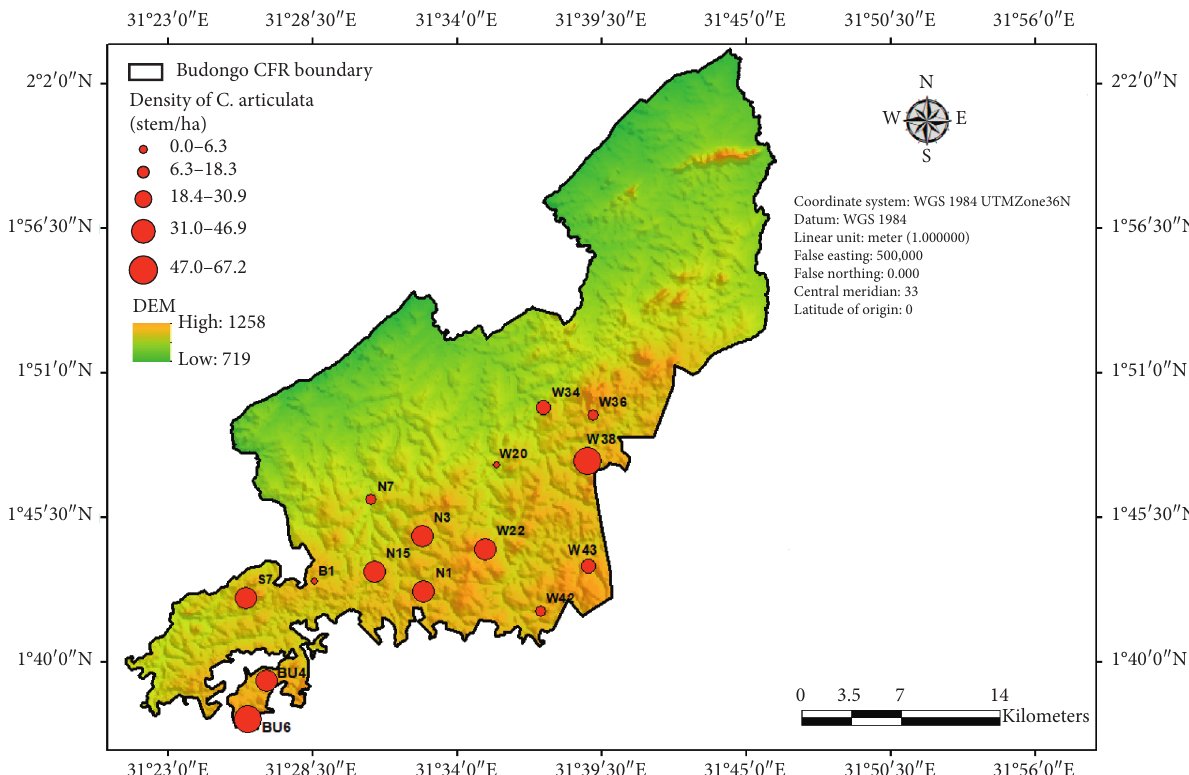
Figure 3: Variability in occurrence of C. articulata in Budongo Central Forest Reserve. B, Biso; Bu, Busaju; N, Nyakafunjo; S, Siiba; W,